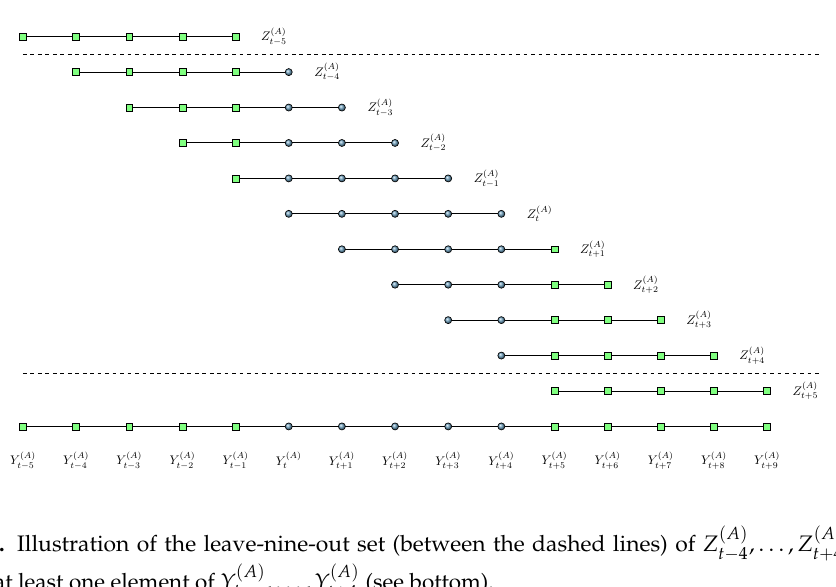
Figure 1. Illustration of the leave-nine-out set (between the dashed lines) of Z include at least one element of Y